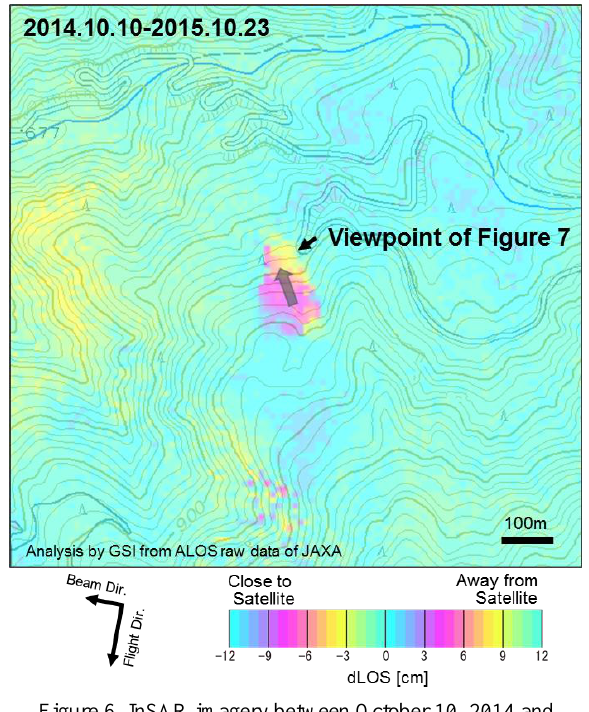
Figure 6. InSAR imagery between October 10, 2014 and October 23, 2015 on GSI Maps in Motoyama-b site. Grey arrow shows the direction of landslide movement estimated from field survey.